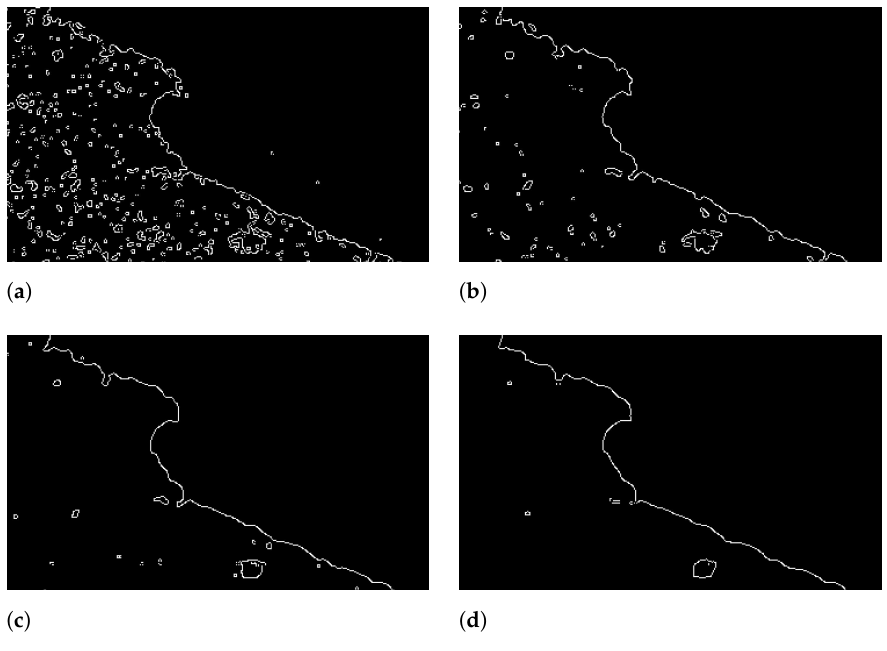
Figure 8. Example of the influence of the despeckling kernel size in the final retrieval of the edges. Result obtained by using a median-filtering approach by varying the kernel size in order to reduce speckle noise: ( a ) kernel size 3 × 3; ( b ) kernel size 5 × 5; ( c ) kernel size 7 × 7; ( d ) kernel size 9 ×